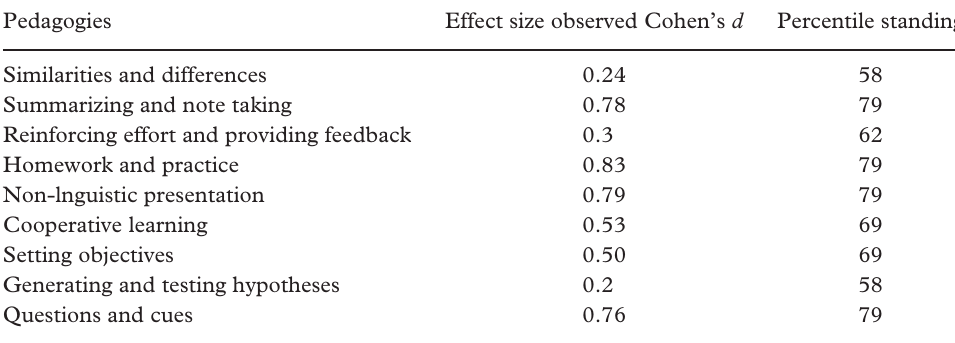
Table 3. Effect sizes and percentile